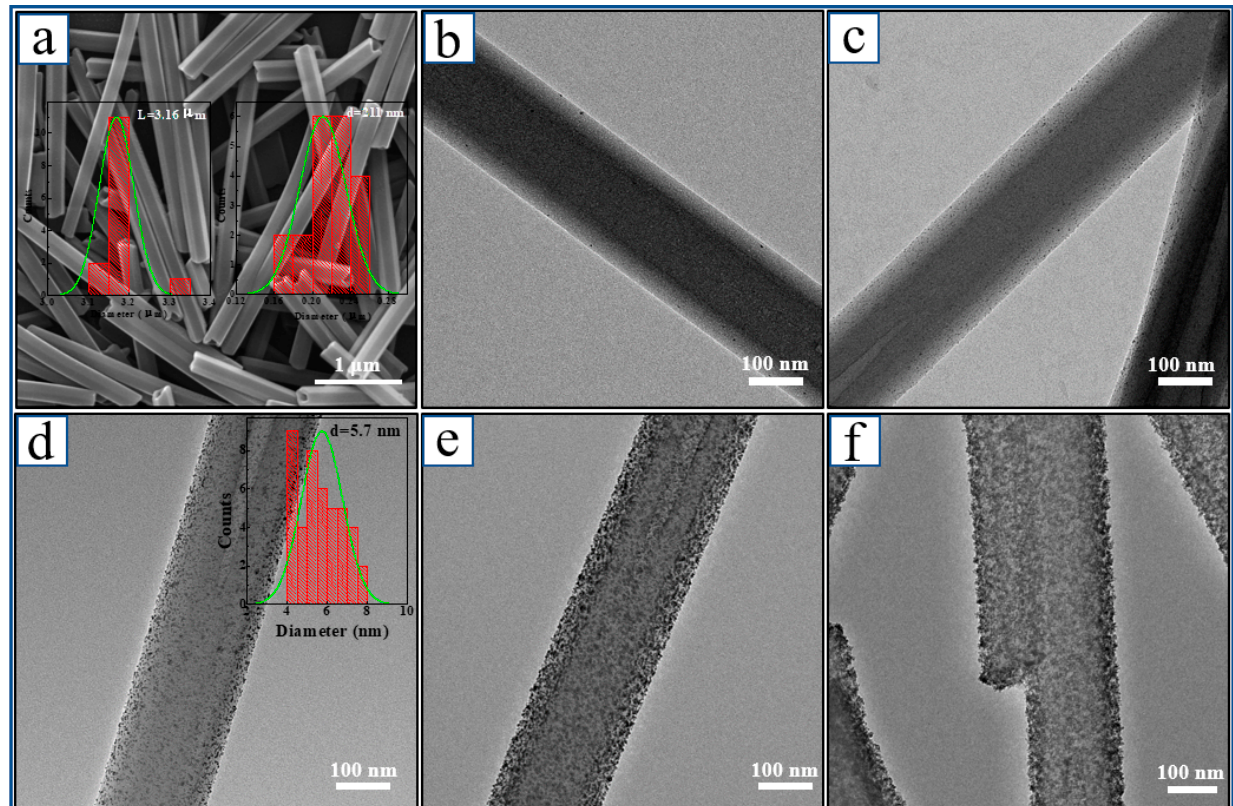
Figure 2. TEM image of one-dimensional M-HW composite: ( a ) porphyrin hexagonal wires (HW) and insert of ( a ) is the size distribution of HW; ( b ) 2.0% Pt-HW; ( c ) 5.6% Pt-HW; ( d ) 9.1% Pt-HW and insert of ( d ) is the size distribution of Pt nanoparticles; ( e ) 23% Pt-HW; ( f ) 45% Pt-HW.